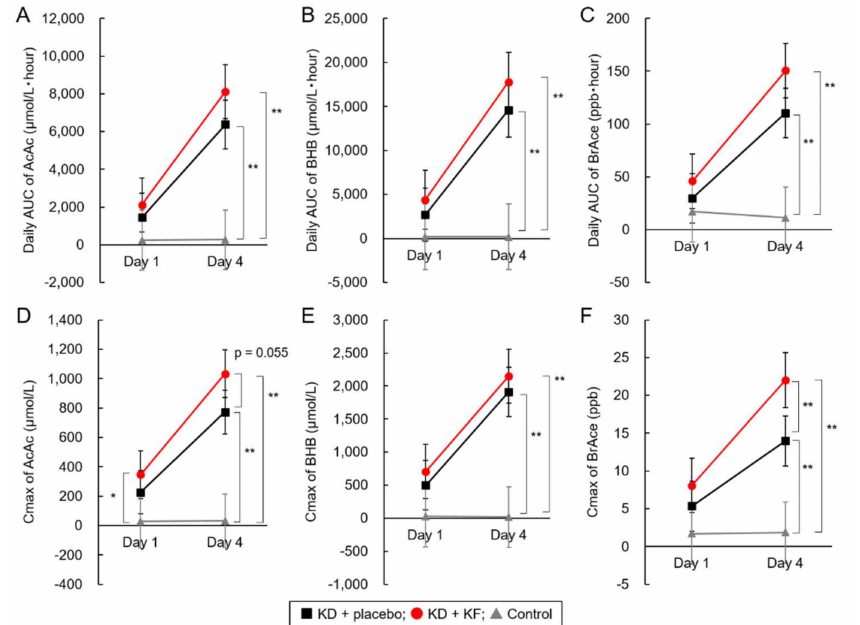
Figure 5. Analysis of the results of secondary endpoints. AUC of plasma AcAc ( A ), BHB ( B ), and breath acetone ( C ) concentrations, and the maximum concentration of plasma AcAc ( D ), BHB ( E ), and breath acetone ( F ). *: p < 0.05, **: p < 0.01, Tukey–Kramer’s test. All parameters in KD + placebo group and KD + KF group changed significantly between Day 1 and Day 4 ( p <